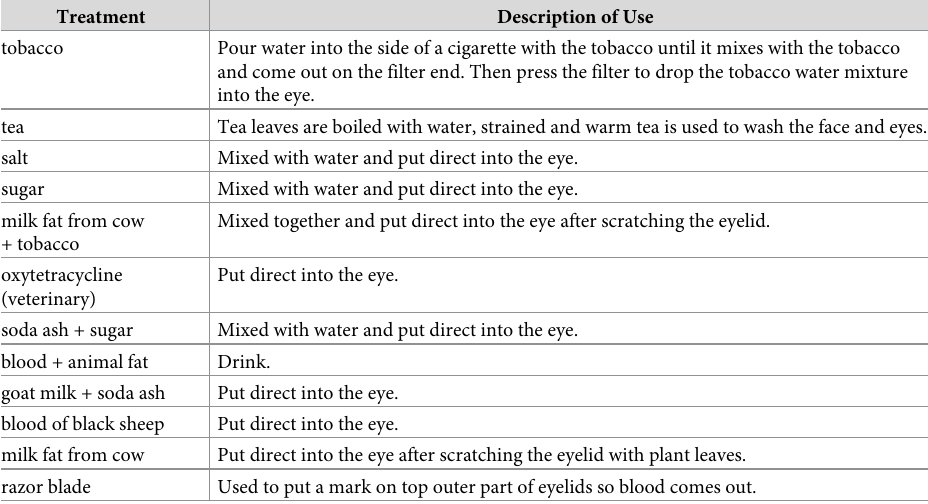
Table 2. Other local treatments for enaoji (eyelid irritation). Pour water into the side of a cigarette with the tobacco until it mixes with the tobacco and come out on the filter end. Then press the filter to drop the tobacco water mixture into the eye. Tea leaves are boiled with water, strained and warm tea is used to wash the face and eyes. Mixed with water and put direct into the eye. Mixed with water and put direct into the eye. Mixed together and put direct into the eye after scratching the eyelid. Put direct into the eye. Mixed with water and put direct into the eye. Put direct into the eye. Put direct into the eye. Put direct into the eye after scratching the eyelid with plant leaves.